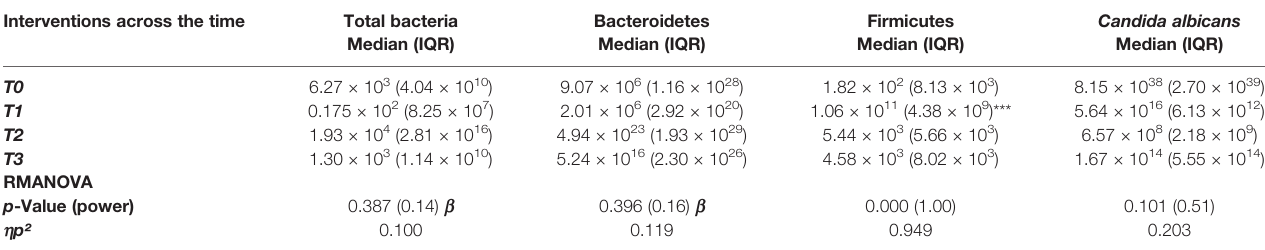
TABLE 1 | Within subjects ’ effects of antiseptic and antibiotic intervention across the time in total bacteria, Bacteroidetes and Firmicutes Phyla, and C. albicans : a repeated measures analysis of variance. Interventions across the time Total bacteria